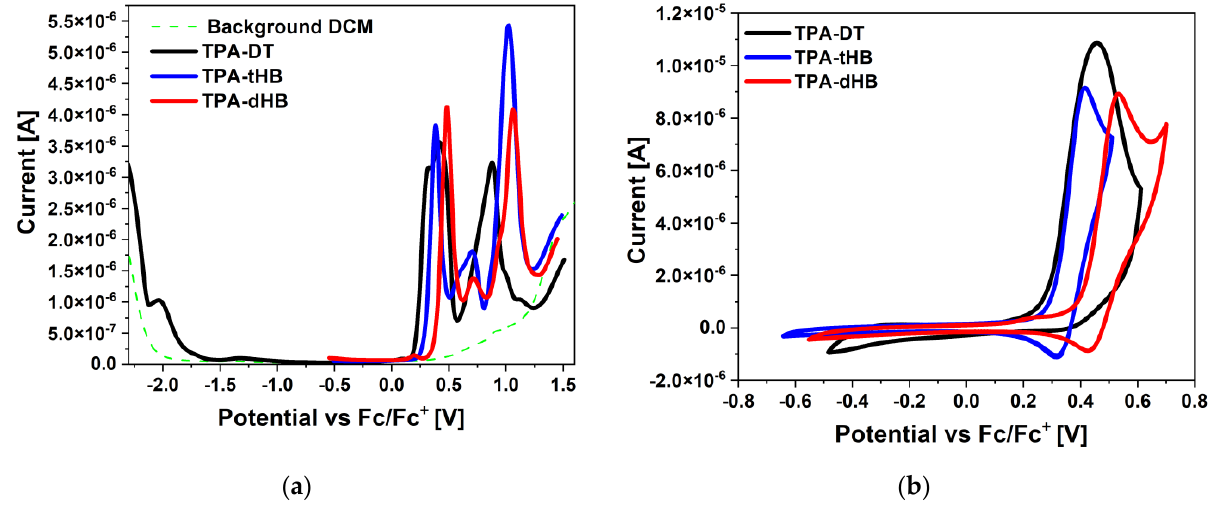
Figure 2. ( a ) DPV and ( b ) CV scans during reduction and oxidation processes (0.1 mol/dm 3 Bu 4 NPF 6 in CH 2 Cl 2 with Pt). Table 2. The electrochemical properties (E HOMO , E LUMO , E g ) of the investigated